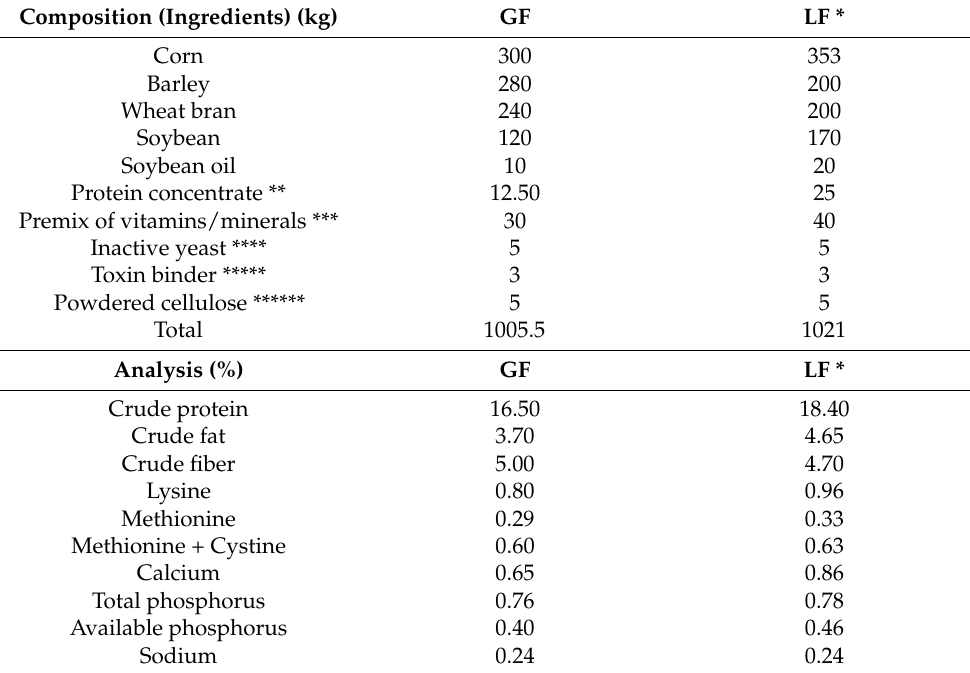
Table 1. Composition (kg) and calculated analysis (%) of gestation feed (GF) and lactation feed (LF) of sows’